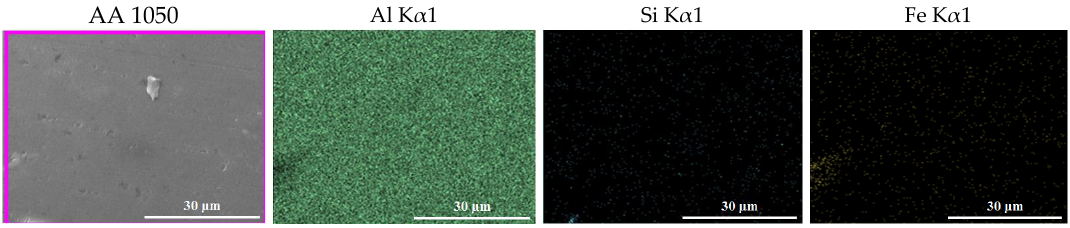
Figure A1. EDS mapping of AA 1050. Coatings 2019 , 9 , x FOR PEER REVIEW